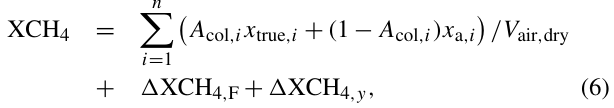
derived from ECMWF specific humidity (cm − 2 ) Aerosol column N aer derived from aerosol optical thickness = 0.1 at 760nm (cm − 2 ) Aerosol size parameter α 3.5 (–) Aerosol height parameter z aer 5000 (m) Lambertian surface albedo in the NIR band maximum of measured reflectance in the NIR band (–) First-order spectral dependence surface albedo in the NIR band 0 (–) Lambertian surface albedo in the SWIR band maximum of measured reflectance in the SWIR band (–) First-order spectral dependence surface albedo in the SWIR band 0